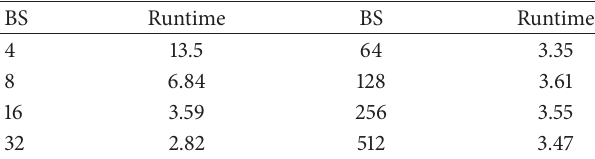
Table 6: Impact of thread block size